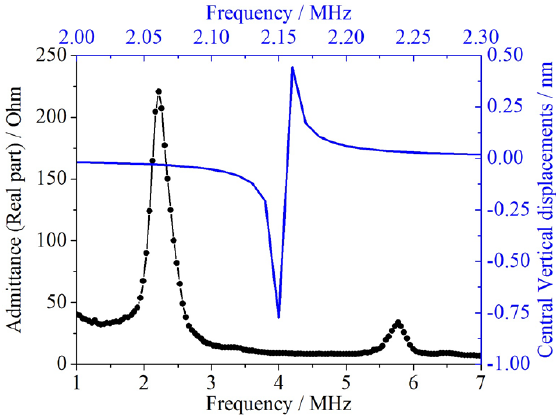
Figure 9. The testing results and FEM simulations of the double-layer CMUT membrane. The black solid line represents the experimental data, arranged against the bottom x -axis and left y -axis in black. The blue solid line denotes the FEM simulations, arranged against the top x -axis and right y -axis in blue. The first peak of the experimental data is the first-order response frequency, and the second peak is the second-order response frequency. Table 6. Response frequency error analyses of the double-layer CMUT membrane for 20 V. Experimental Data (MHz)